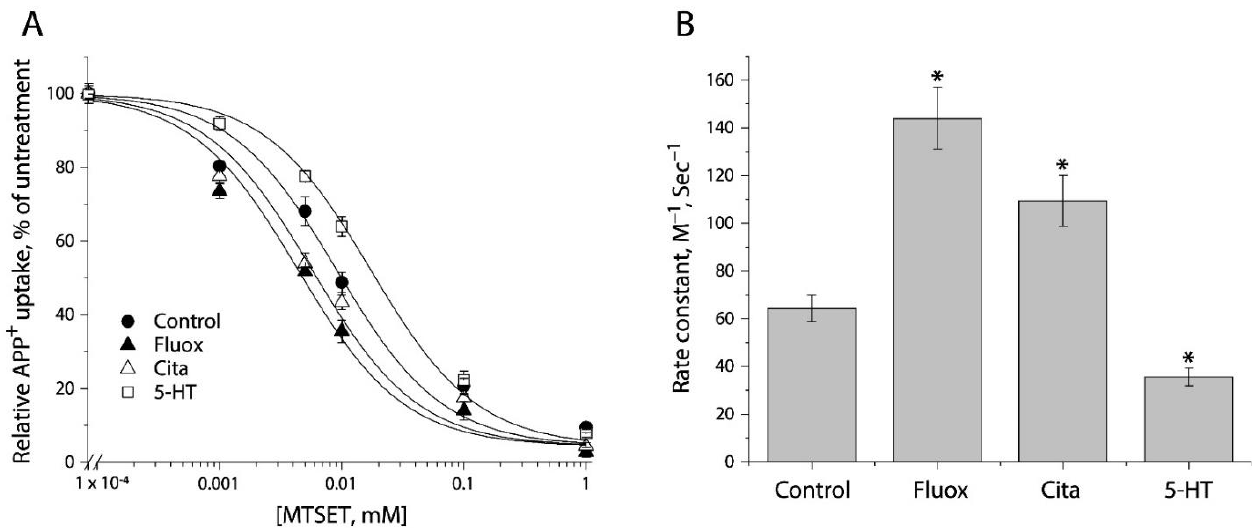
Figure 4. The effects of antidepressants and substrate on MTSET inactivation of APP + uptake by Y107C/C109A. ( A ) MTSET concentration-dependent inhibition of APP + uptake. The cells stably expressing Y107C/C109A were treated for 15 min with indicated concentrations of MTSET in the absence or presence of 10 µ M fluoxetine (Fluox), citalopram (Cita) or 5-HT. After washing to remove excess MTSET and ligands, APP + uptake was measured as described under “Materials and Methods”. The graph shows a representative experiment. The experiment was repeated twice with similar results. ( B ) Rate constants of MTSET inhibition of APP + uptake. The IC 50 values of MTSET inhibition were used to calculate rate constants as described under “Materials and Methods”. Error bars represent SEM from three experiments. Asterisks indicate statistically significant changes ( p < 0.05) in rate constant compared to the control (MTSET alone).